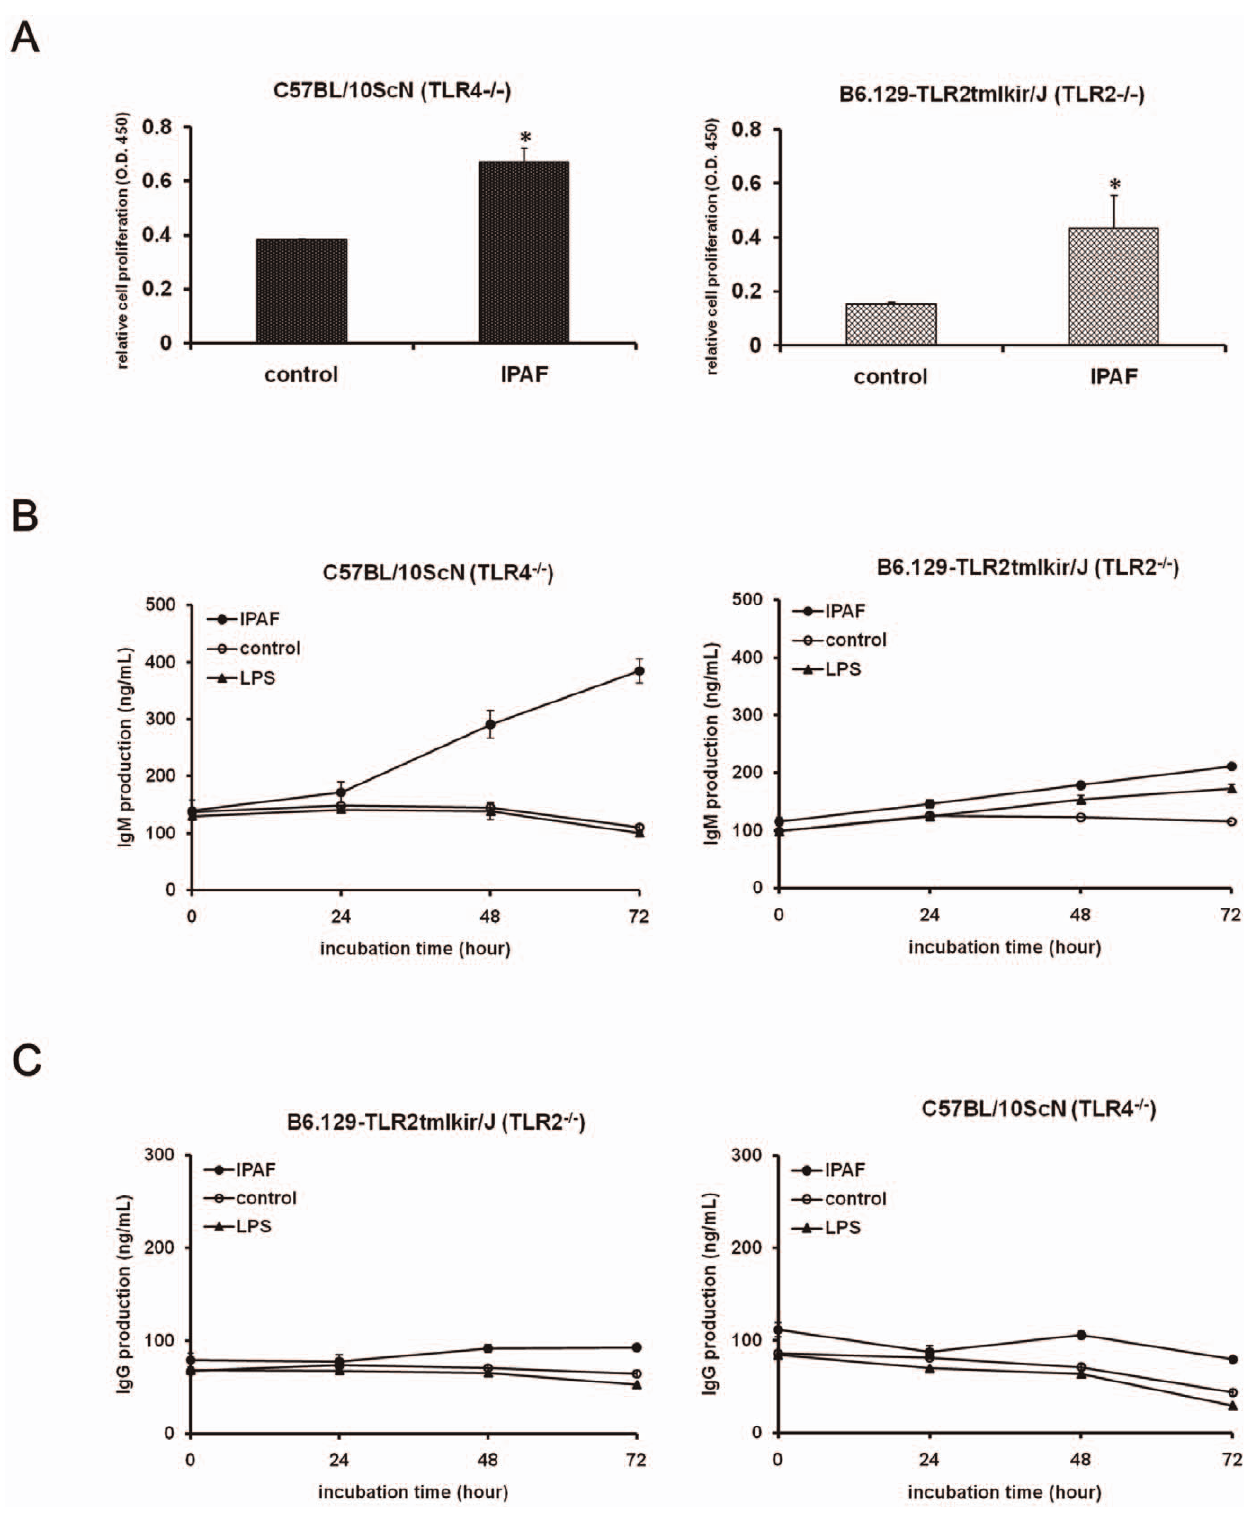
Figure 6. TLR2 and TLR4 were not involved in the IPAF-induced activation of mouse splenic B lymphocytes. (A–B) B lymphocytes of C57BL/10ScN (TLR4 2 / 2 ) and B6.129-TLR2tmlkir/J (TLR2 2 / 2 ) were treated with 30 m g/mL of IPAF ( N ), medium ( # ), or 10 m g/mL LPS ( m ) for 0, 24, 48 and 72 hours, the IgM (A) and IgG (B) production were determined by ELISA. (C) B lymphocytes of C57BL/10ScN and B6.129-TLR2tmlkir/J were treated with or without 30 m g/ml IPAF for 48 hours, and the cell proliferation was analyzed by Brd-U assay. Results are shown as mean 6 SD in triplicate (n=3). *P , 0.05 versus control.